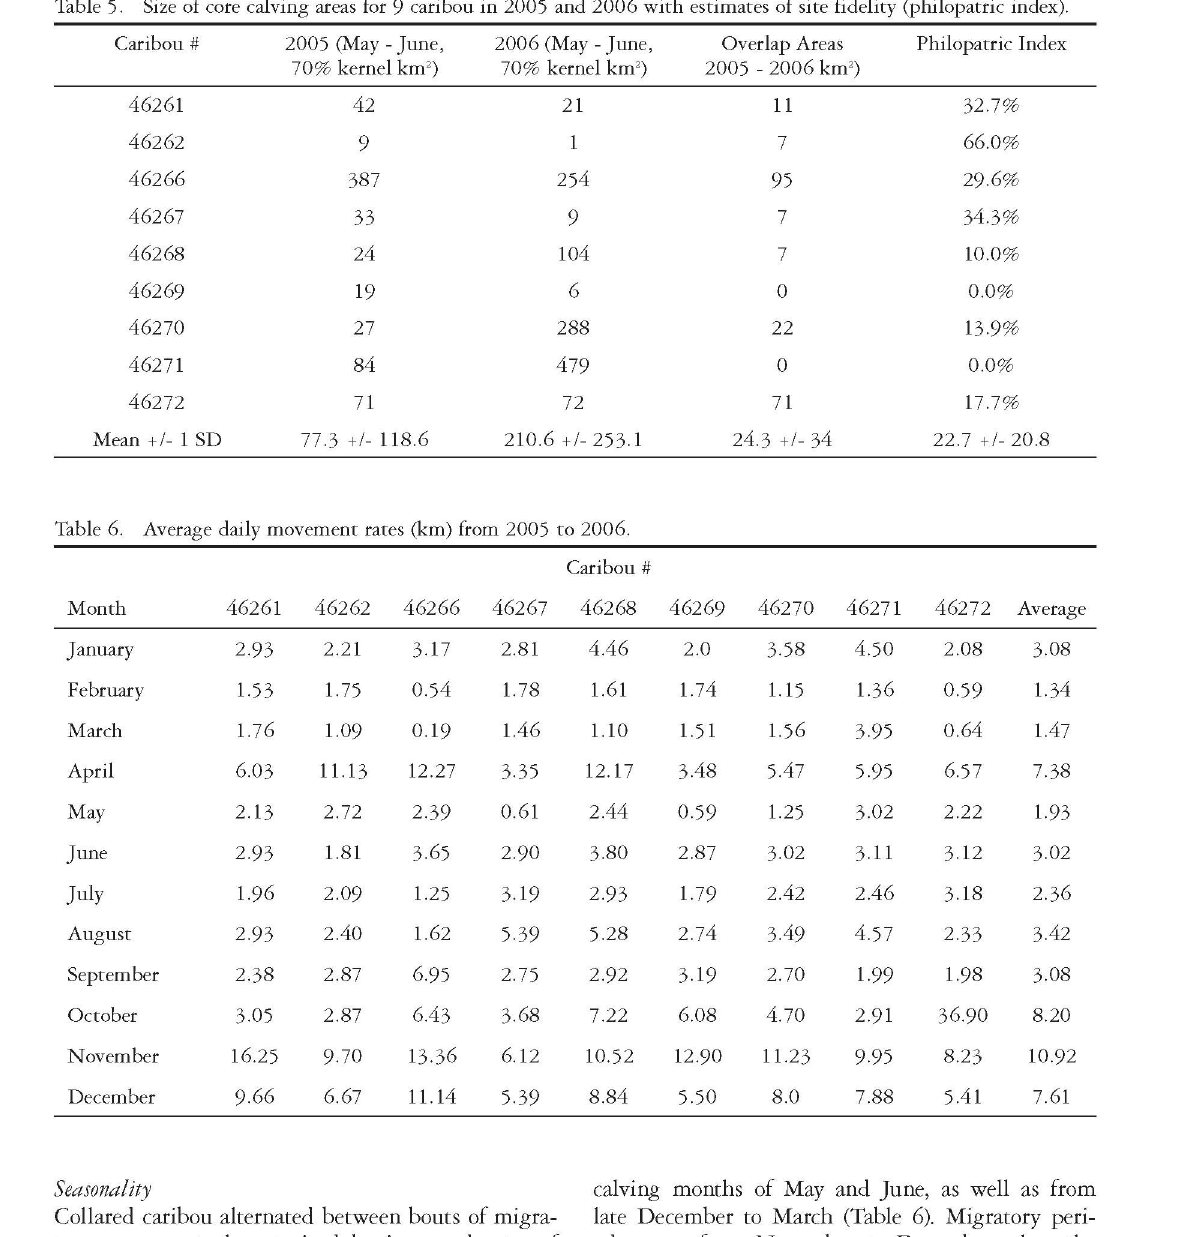
Table 6. Average daily movement rates (km) from 2005 to